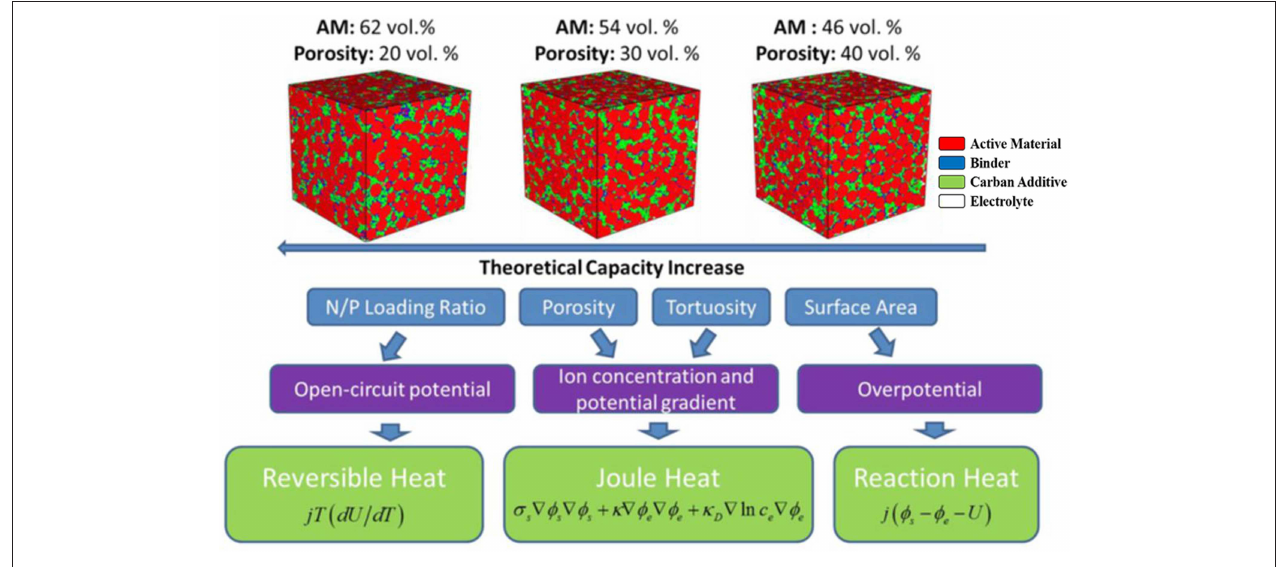
FIGURE 9 | Interaction between microstructure and heat generation (Chen et al.,